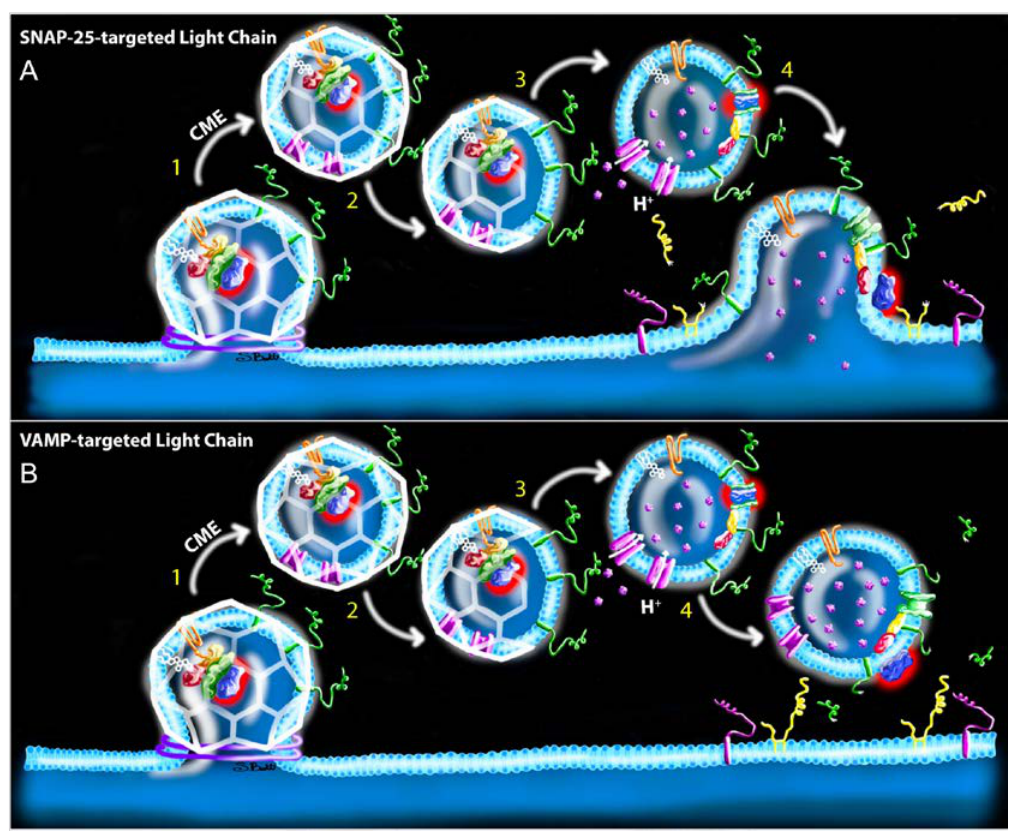
Figure 4. Hypothesized mechanisms of toxin uptake and LC activity following CME. ( A ) VAMP-targeted LC. Following dynamin-dependent, clathrin-coated endocytosis (step 1), the clathrin coat (white) is disassembled (step 2) and the vATPase proton pump (pink) acidifies the endosome, allowing LC (blue with red halo) translocation to the cytosolic membrane surface (step 3). Translocated vLC cleaves VAMP proteins (green), producing fusion-incompetent SVs that are able to release sites (step 4). ( B ) SNAP-25-targeted LC. Steps 1–3 are as identical as the top panel.